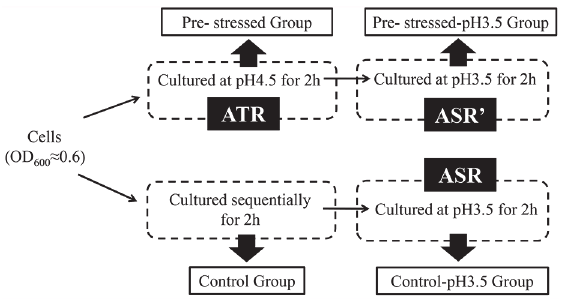
Fig 1. Schematic of the experimental design. Cultures in the mid-exponential phase (OD 600 = 0.6) were harvested and divided into two. Half of the cells were cultured for 2 h in the original medium, serving as the control group, and the other half of the cells wereculturedat pH 4.5 for 2 h, serving as the pre-stressed group. Then, the cells from both groups were harvested and challengedat a lethal pH 3.5 for 2 h. The resulting cells served as the control-pH 3.5 group and the pre-stressed-pH 3.5 group. ATR, response to pH 4.5; ASR, response to pH 3.5 of the cells in the control group; ASR, response to pH 3.5 of the cells in the pre- stressed